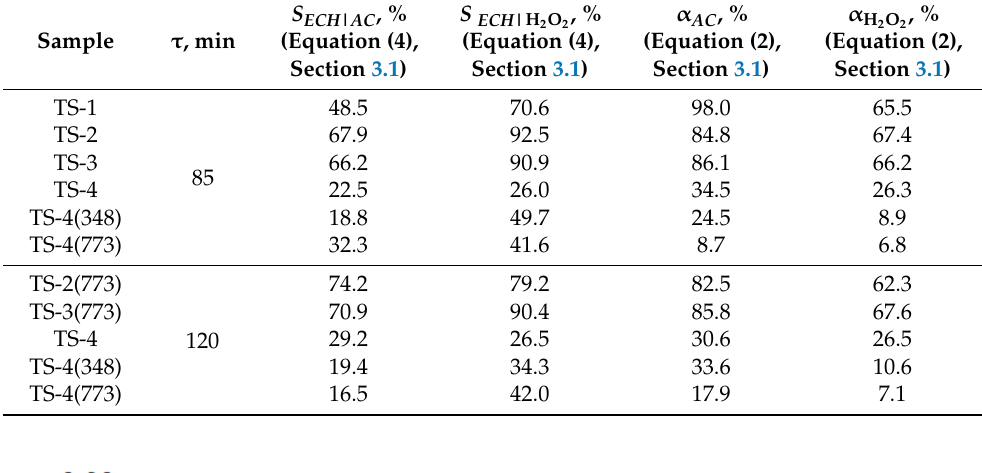
Table 15. Comparison of the main parameters for the process of allyl chloride ( AC ) epoxidation to epichlorohydrin ( ECH ) on titanosilicalite catalysts (T = 303 K, atmospheric pressure, C ECH = C H2O2 = 2.35 mol/L) (data from [33,34]).